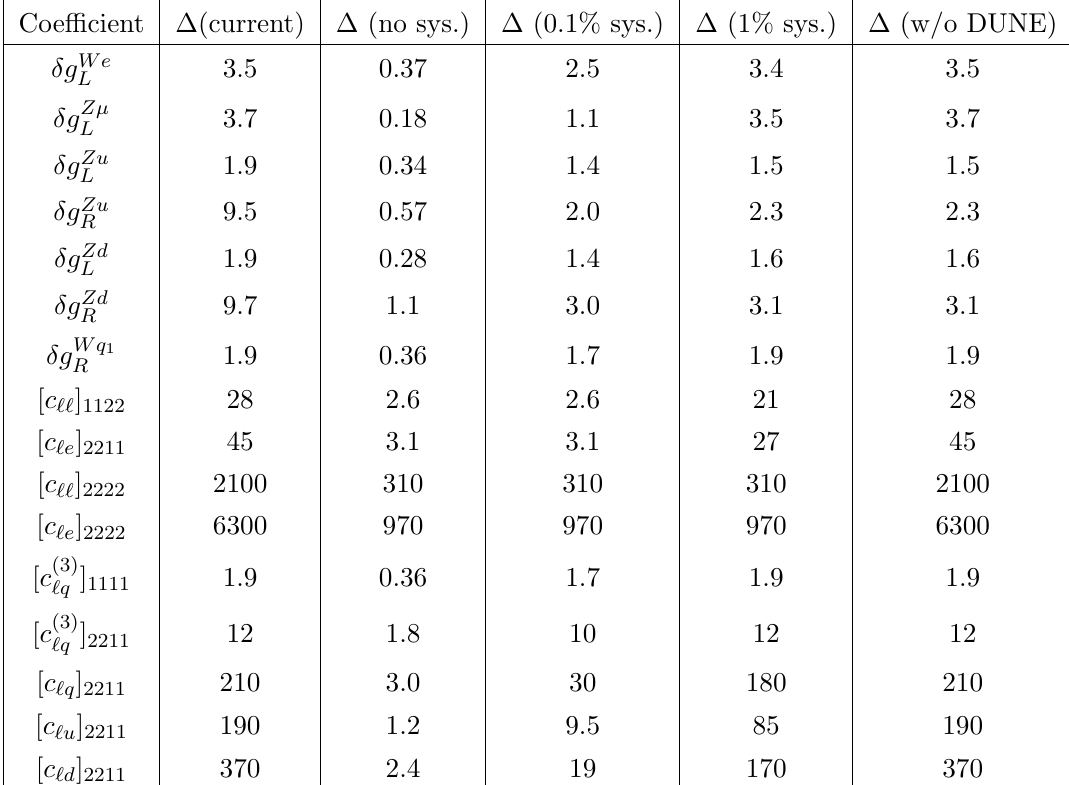
Table 6 . 1 (cid:27) uncertainty (cid:1) in units of 10 (cid:0) 4 on SMEFT Wilson coe(cid:14)cient from current and future low-energy precision measurements, assuming only one Wilson coe(cid:14)cient is non-zero at a time. We display only those coe(cid:14)cients in the Higgs basis for which the constraints can be improved by at least a factor of (cid:12)ve in the best-case scenario. The current uncertainties are extracted from ref. [10], while the future ones also include projections from (cid:23) scattering on electrons and nucleons and trident production in DUNE, as well from APV and parity-violating electron scattering experiments discussed in section 4. The future constraints are shown under three di(cid:11)erent hypotheses about the size of systematic errors in DUNE. The (cid:12)nal column shows the future projections without the DUNE